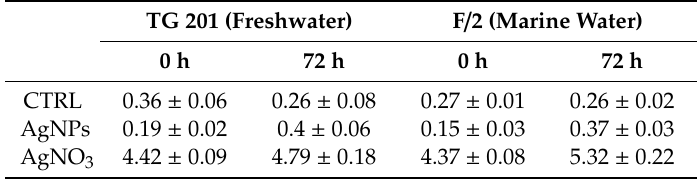
Table 1. Ag + concentrations (expressed as µ g / L) in freshwater and marine waters with algal medium solution (CTRL), as well as algal medium solutions with AgNPs (500 µ g / L) and with AgNO 3 (7 µ g /